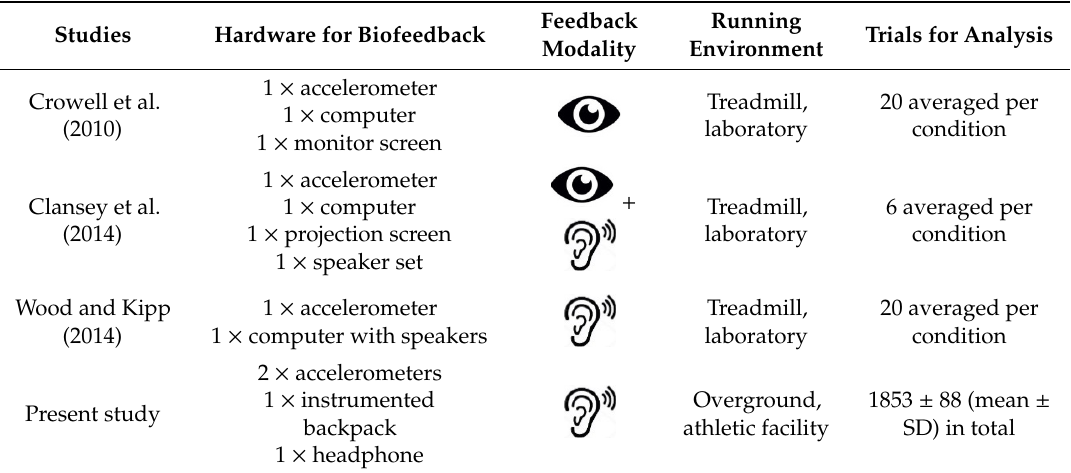
Table 1. Milestones illustrating the technological advancements and feedback modalities on augmented feedback with respect to tibial acceleration. The eye and ear icons indicate visual and auditory feedback, respectively.